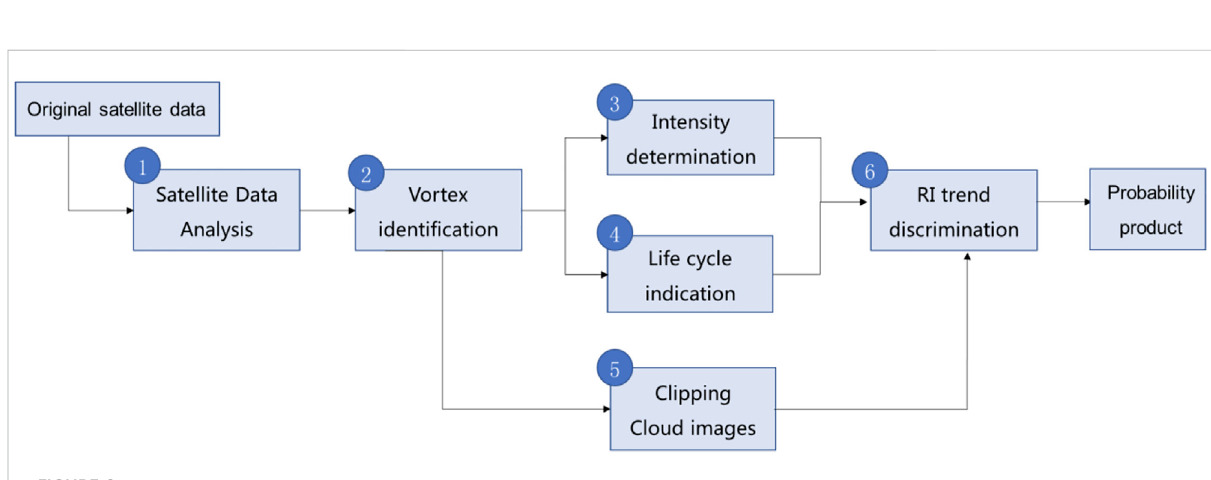
FIGURE 8 Flowchart of AI-based typhoon monitoring and forecasting